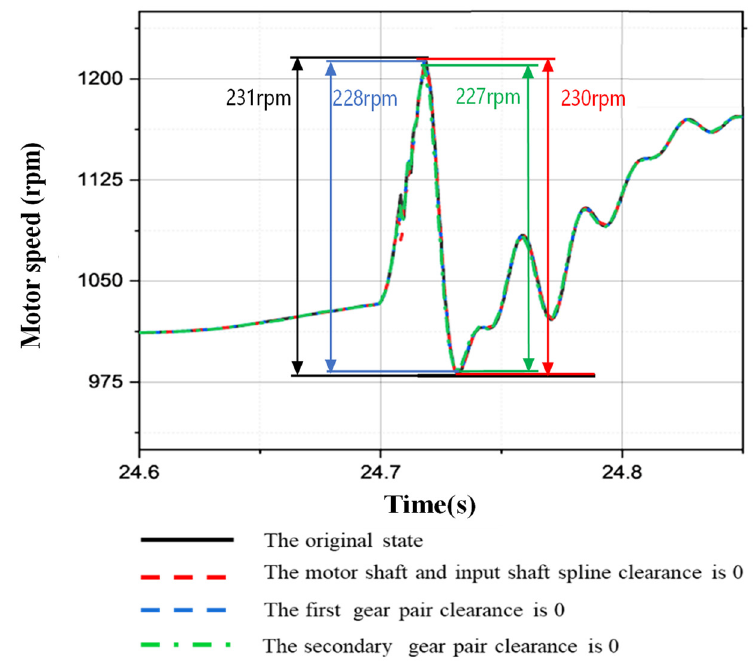
Figure 10. The changes in different gaps of high-speed engagement pairs.